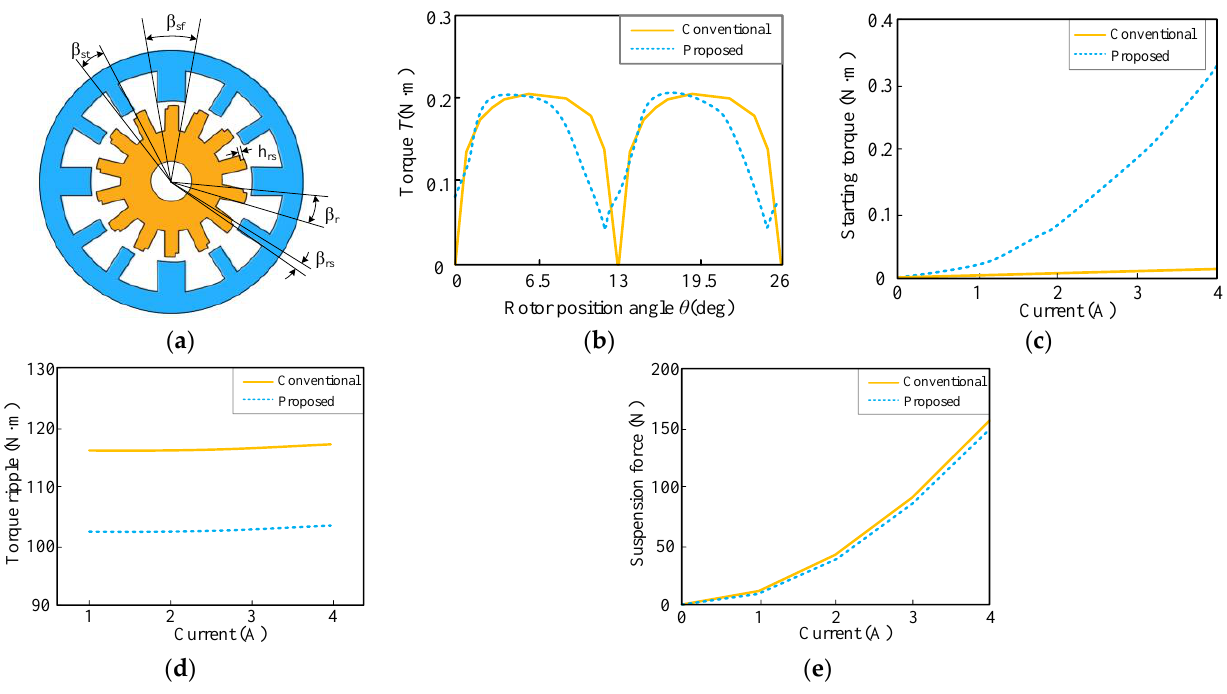
Figure 4. Asymmetric rotor pole hybrid stator BSRM: ( a ) Structure of asymmetric rotor pole hybrid stator BSRM; ( b ) Torque characteristics of conventional and proposed BSRMs; ( c ) Starting torque in conventional and proposed BSRMs; ( d ) Torque ripple in conventional and proposed BSRMs; and ( e ) Average suspension force in conventional and proposed BSRMs.